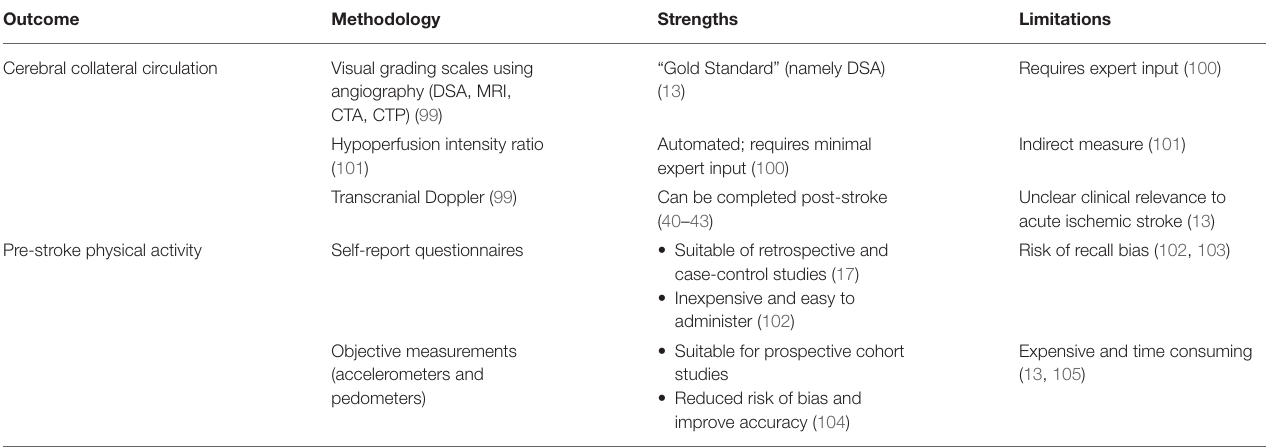
TABLE 2 | Measurement considerations for cerebral collateral circulation and pre-stroke physical activity.